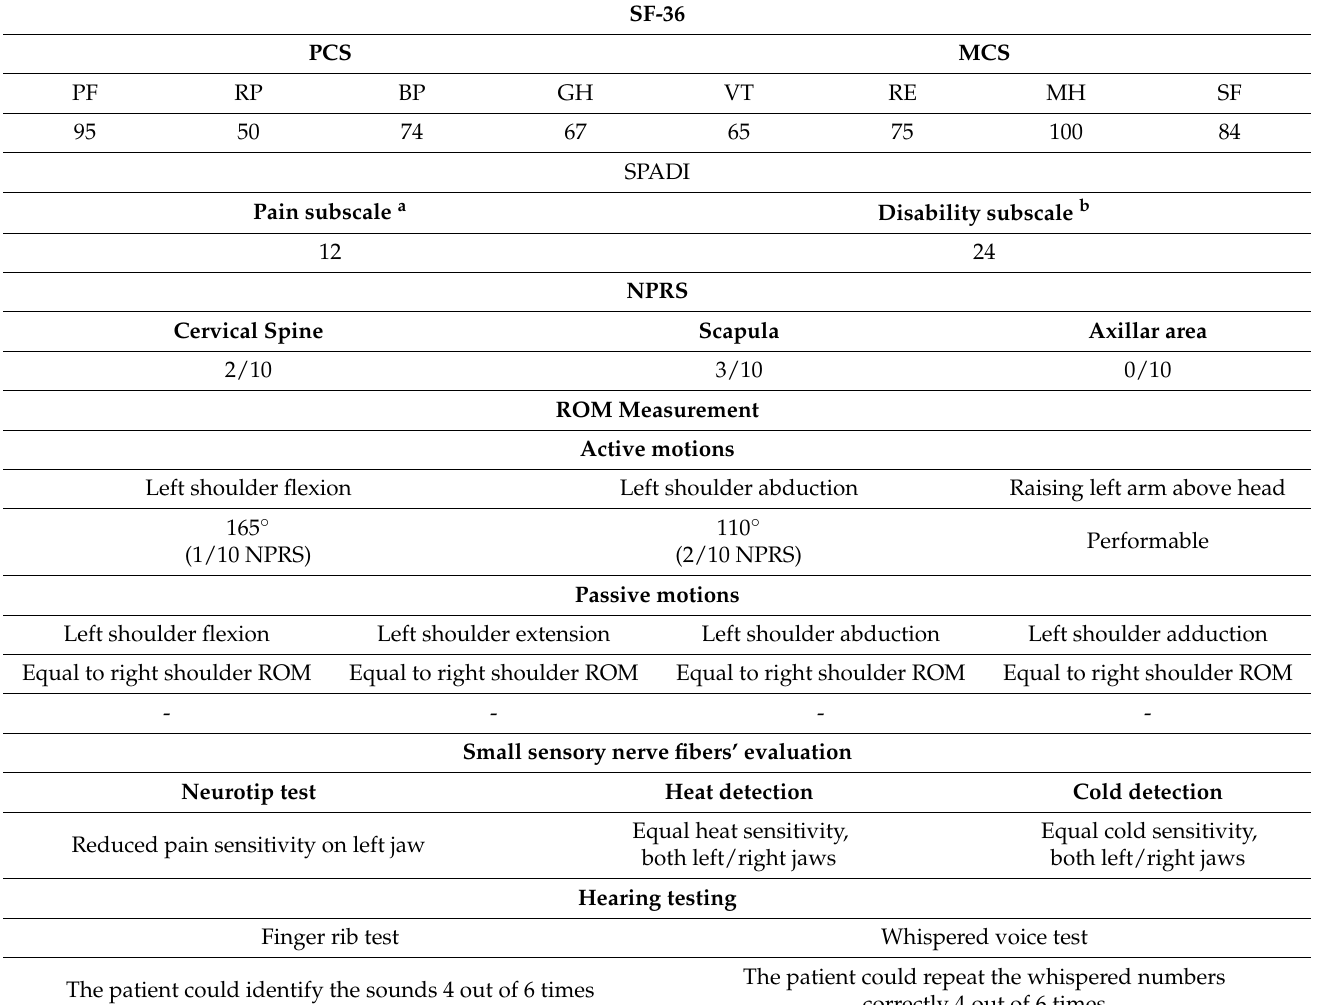
Table 3. Outcome measure. Follow-up